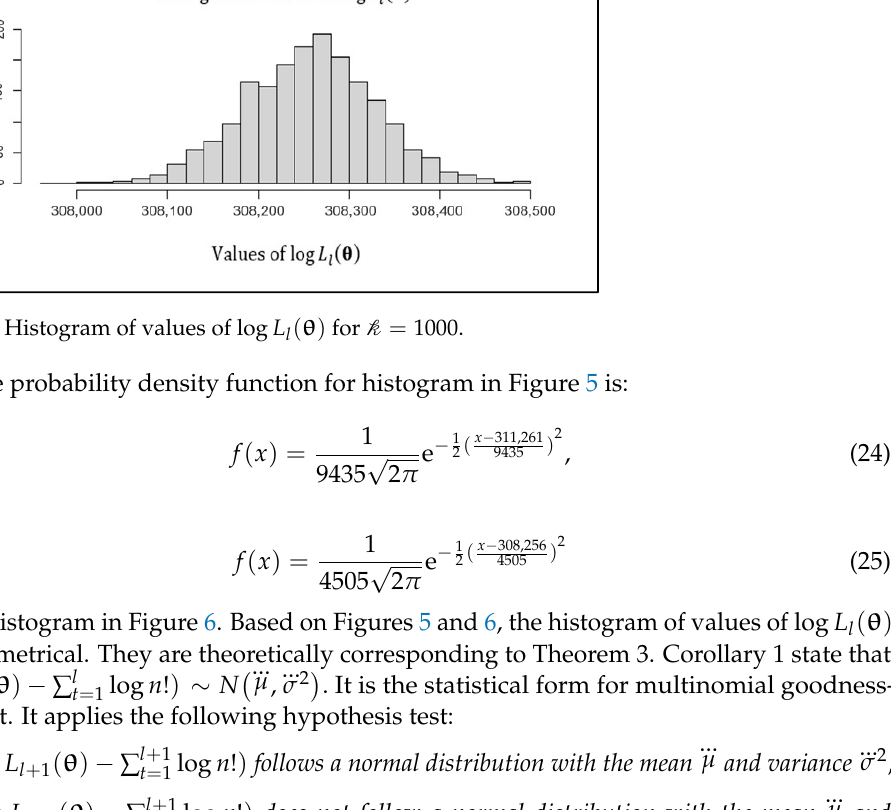
Figure 5. Histogram of values of log𝐿 (cid:3039) (θ) for 𝓀 = 2000 . Next, as an illustration, the values of log 𝐿 (cid:3039) (𝛉) , where 𝑚 = 260, 𝑛 = 1,738,665, 𝑙 = 30, for 𝓀 = 1000, are shown in Figure 6.